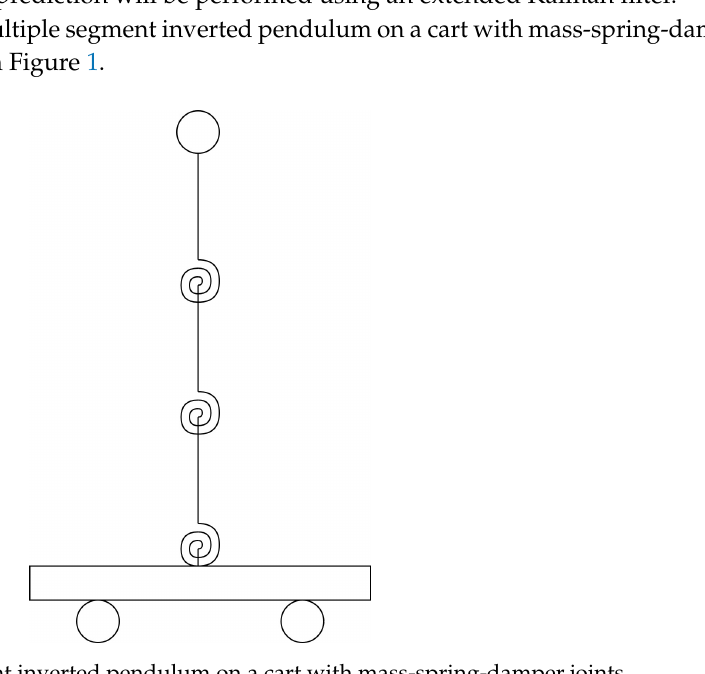
Figure 1. Three segment inverted pendulum on a cart with mass-spring-damper